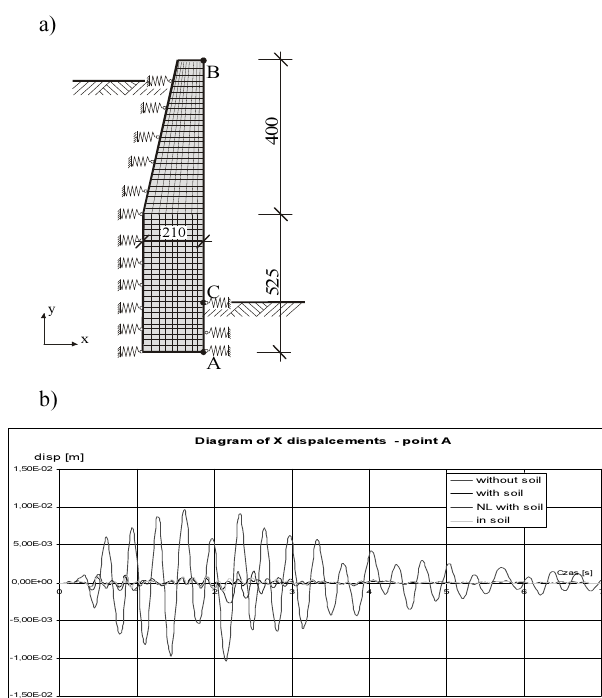
Fig. 14. Model of dynamic response of soil-retaining wall (a); displacement diagram